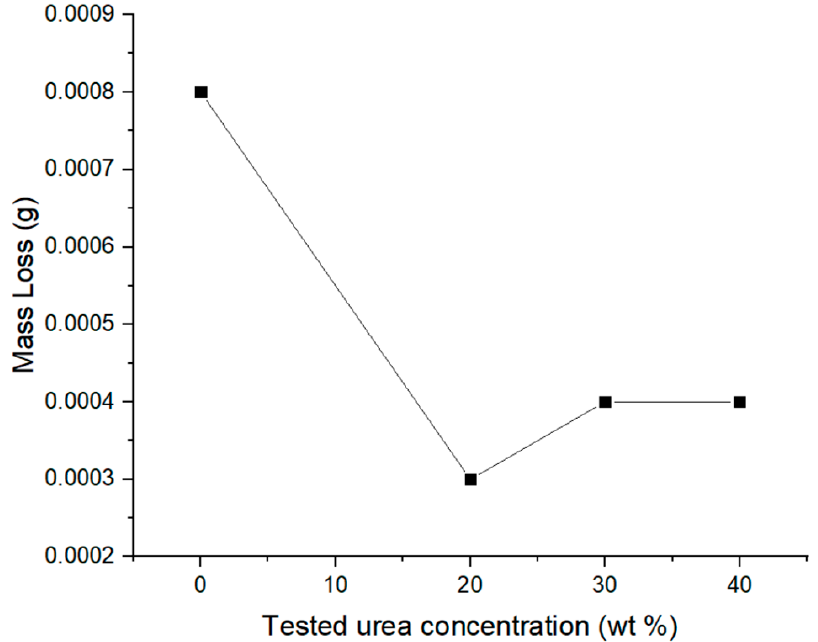
Figure 9. Wear of the oxy-nitrided samples according to the ASTM G99 standard for a sliding distance of 60 m.